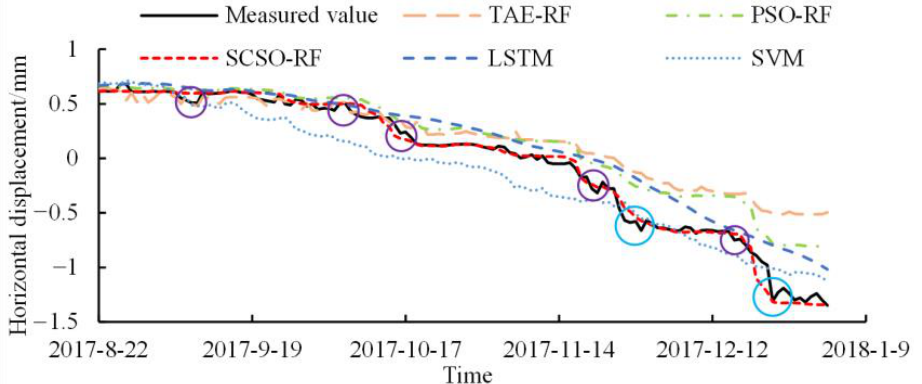
Figure 13. Prediction curves of models.